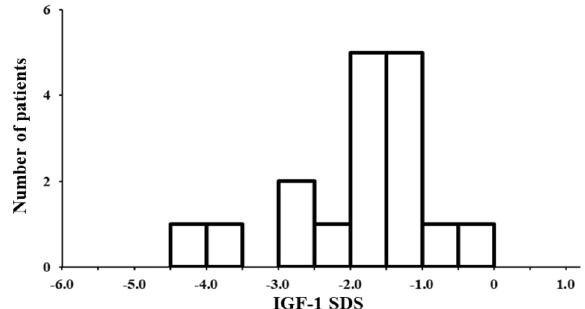
Figure 2. Histogram showing the number of the patients without diabetes per IGF-1 SDS category. IGF-1 insulin like growth factor-1, SDS standard deviation score.